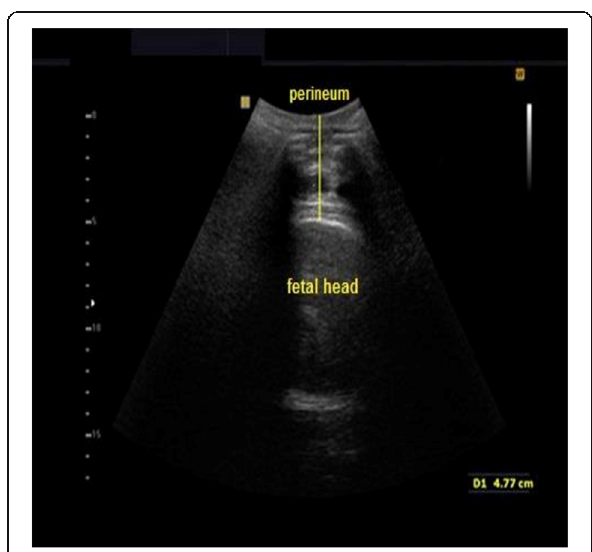
Fig. 6 Fetal head perineum distance (4). HPD is 4.77 cm rounded up to 5 cm measured by